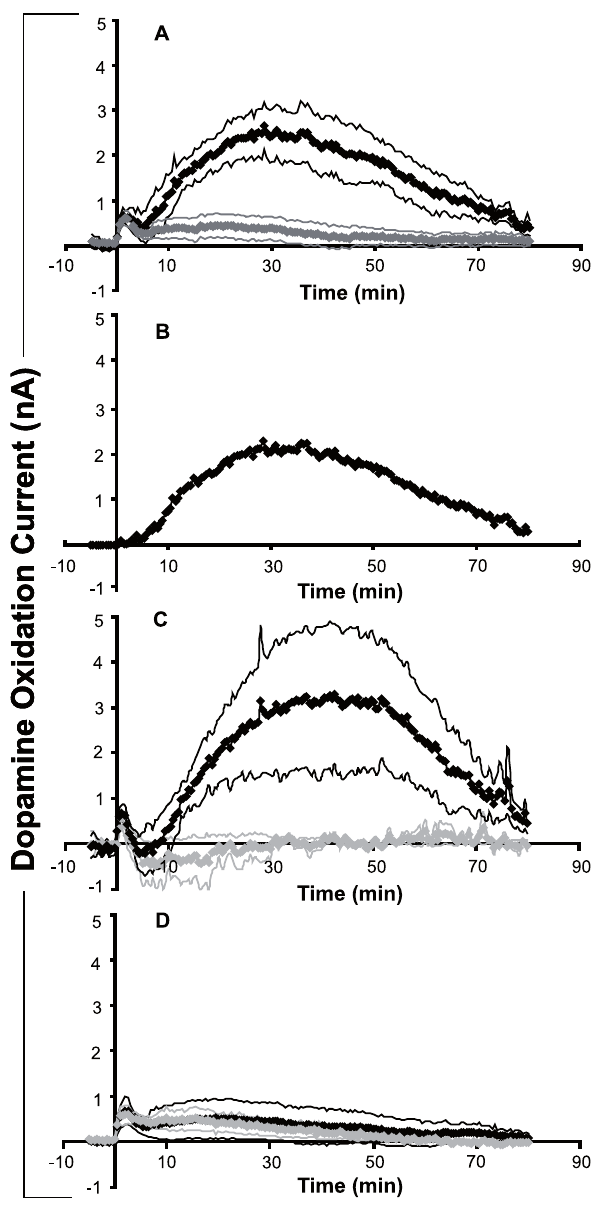
Figure 4. Striatal dopamine efflux following electrical stimula- tion of the PPT in wildtype and M 5 knockout mice. In all cases thick lines represent mean oxidation current corresponding to striatal dopamine efflux across mice, and thin lines represent 6 SEM. (A) PPT- evoked striatal dopamine efflux in wildtype (black trace, n=7) and M 5 knockout (gray trace, n=7) mice. (B) M 5 receptor contribution to PPT- evoked striatal dopamine efflux in mice. The graph shows the difference in dopamine efflux between wildtype (n=7) and M 5 knockout (n=7) mice. (C) Effects of scopolamine (5 mg/kg, i.p.) pre-treatment on PPT- evoked striatal dopamine efflux in 4 of the wildtype mice shown in (A). The black trace shows PPT-evoked dopamine efflux, and the gray trace shows PPT-evoked dopamine efflux following systemic scopolamine. (D) Effects of scopolamine (5 mg/kg, i.p.) pre-treatment on PPT-evoked striatal dopamine efflux in 4 of the M 5 knockout mice shown in (A). The black trace shows PPT-evoked dopamine efflux and the gray trace shows PPT-evoked dopamine efflux following systemic